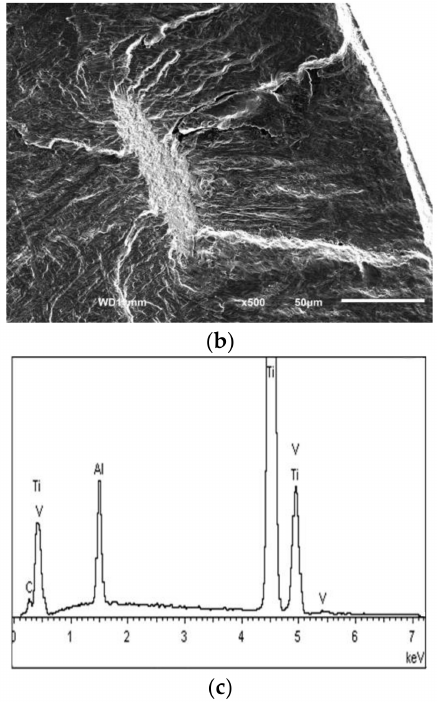
Figure 10. Fracture surface of TC4 (UNSM, 620 MPa, 4.13 × 10 7 cycles): ( a ) Overall view of fracture surface; ( b ) Crack initiation; ( c ) EDX analysis of crack core.